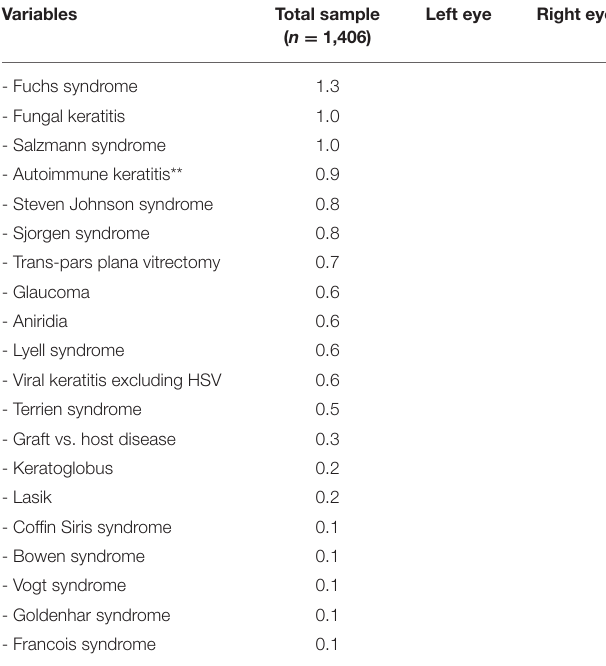
TABLE 1 | Descriptive analysis of the sample of the patients with corneal neovascularization